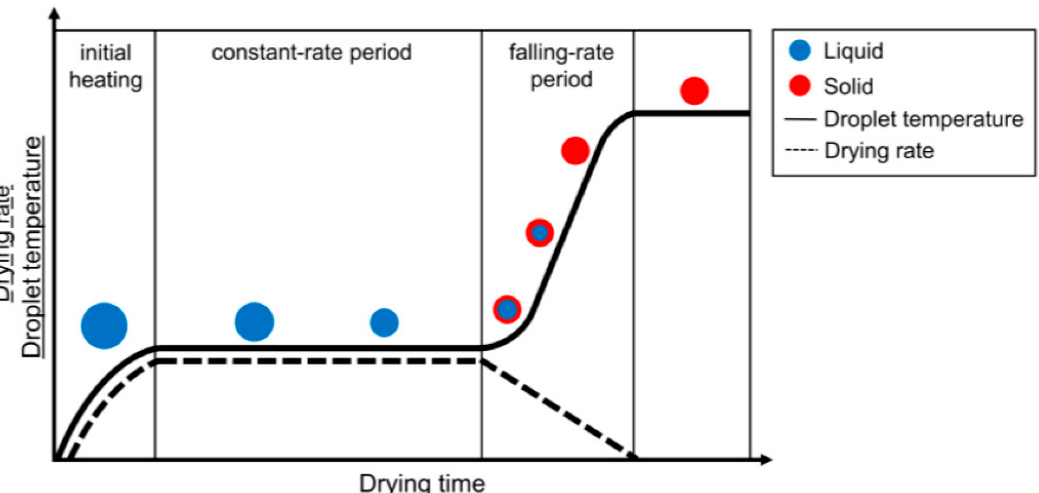
Figure 3. Simplified schematic depiction of the different stages a droplet goes through while drying. Drying rate is represented by a dotted line and temperature evolution by a solid line. The solid fraction is shown in red and the liquid fraction in blue [43,45].